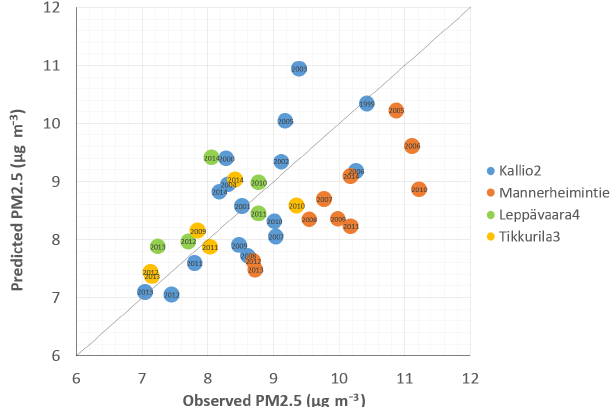
Figure 4. The scatter plot of measured and predicted annual average concentrations of PM 2 . 5 at four measurement stations. The lowest values of both axes have been selected to be 6µgm − 3 .